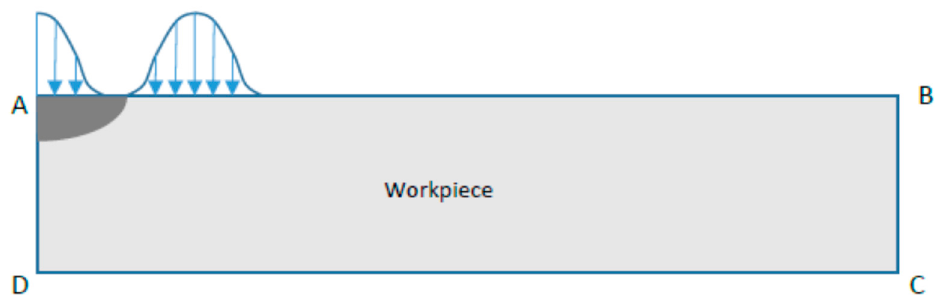
Figure 1. Schematic of model.